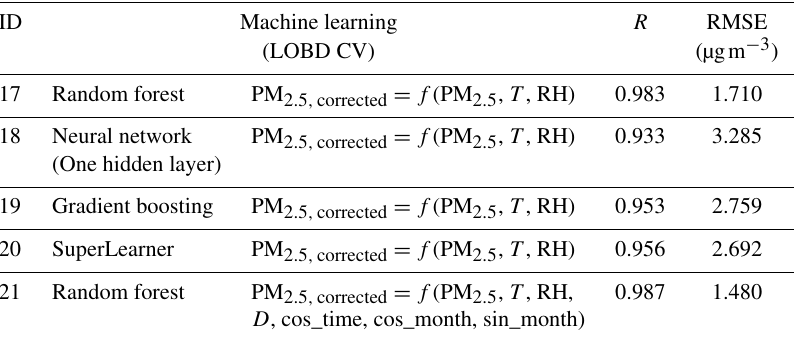
Table 3. Performance of the calibration models using the C1 correction as captured using root mean square error (RMSE) and Pearson correlation ( R ). LOBD CV was used to prevent overfitting in the machine learning